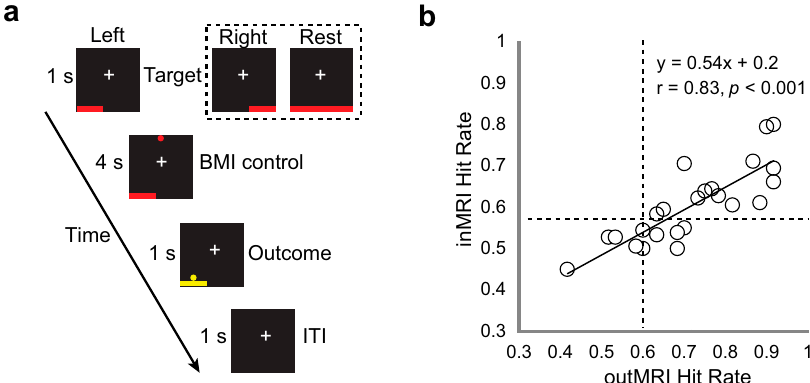
Fig. 1 Experimental design and correlation between hit rates for sessions outside and inside MRI. a An example of a left trial, with right and rest targets shown in the dashed box. ITI, intertrial interval. b Hit rates for sessions outside the MRI (outMRI) are plotted against those inside the MRI (inMRI) for each participant. On average, the inMRI hit rate (mean ± SD, 0.60 ± 0.09) was signi fi cantly lower than the outMRI hit rate (0.72 ± 0.14), as determined using a paired t test (t (23) = 6.9, P < 0.001). However, hit rates were strongly correlated between the inMRI and outMRI sessions ( r = 0.83, P < 0.001). Dashed lines indicate the minimum signi fi cant hit rate (out of 60 trials per task for outMRI and 90 trials per task for inMRI; P < 0.05 for both). Solid line indicates the linear